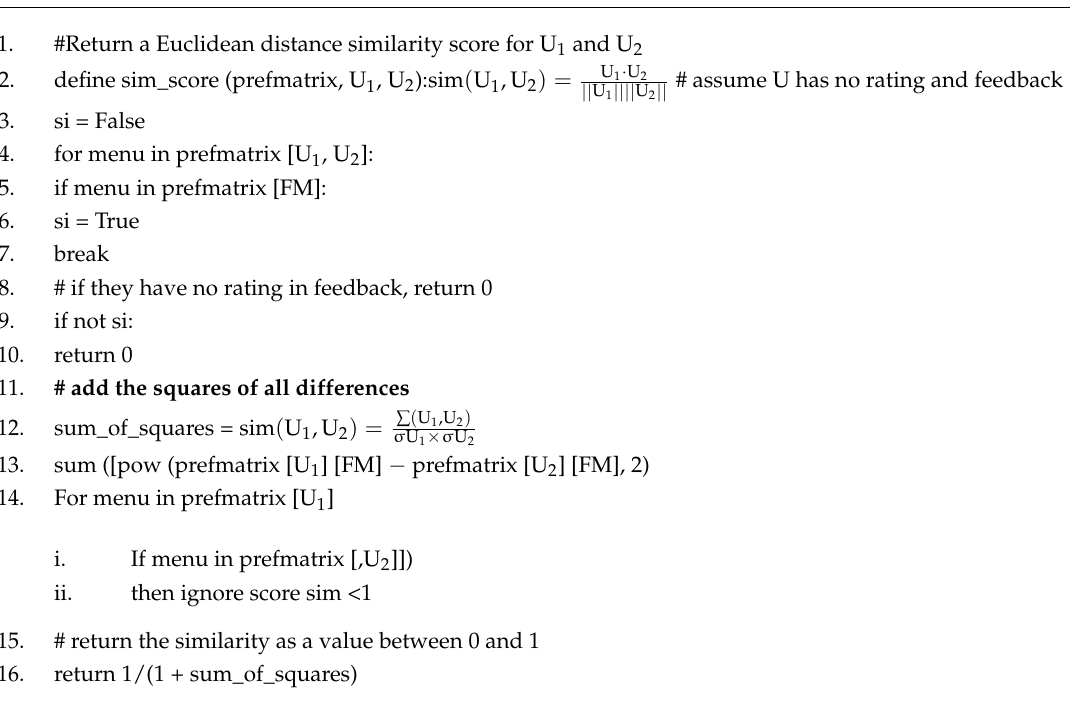
Algorithm 1: Predicting similarities between